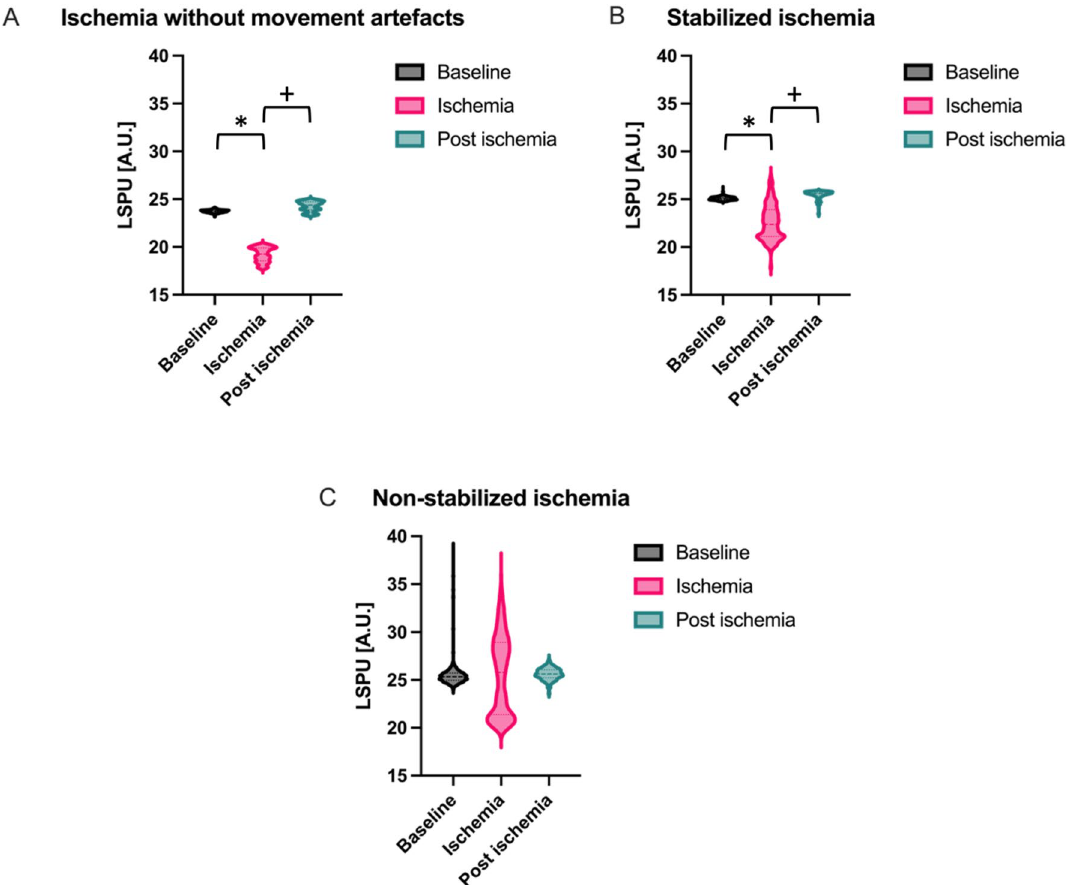
Figure 5. ( A ) Box-and-violin plot of baseline, ischemia and post-ischemia LSPU of local ischemia experiment without movement artefacts. ( B ) Box-and-violin plot of baseline, ischemia and post-ischemia stabilized LSPU of local ischemia experiment with movement artefacts. ( C ) Box-and-violin plot of baseline, ischemia and post-ischemia non stabilized LSPU of local ischemia experiment with movement artefacts. * = ischemia is significantly different from baseline. + = Post occlusion is significantly different from